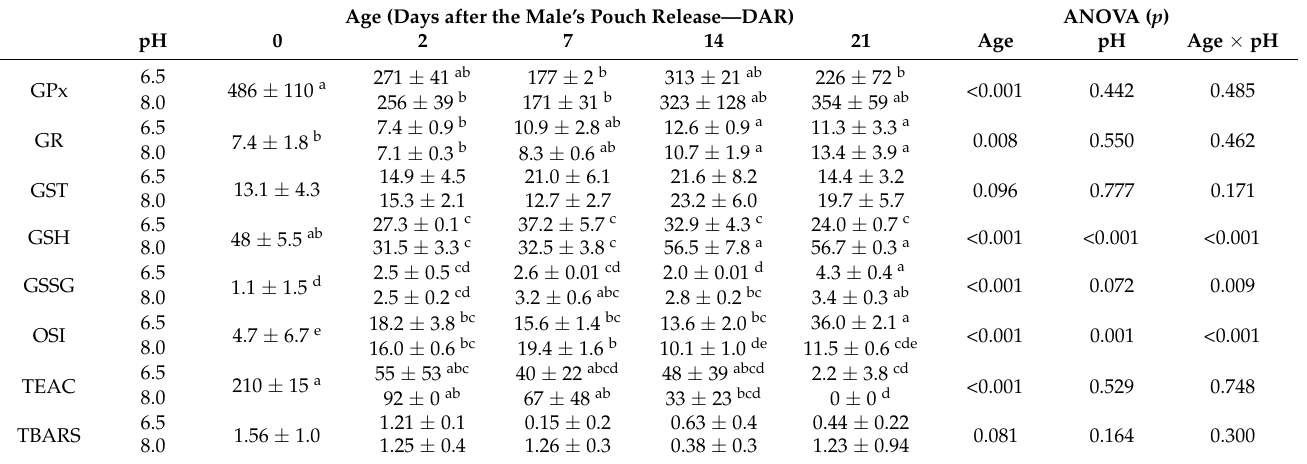
Table 7. Trial 1 (BW)—Glutathione metabolism (mean ± standard deviation) in Hippocampus reidi juveniles reared in brackish water (BW—salinity 11) at pH 6.5 or 8.0 for 21 days (age 0–21 DAR—days after the male’s pouch